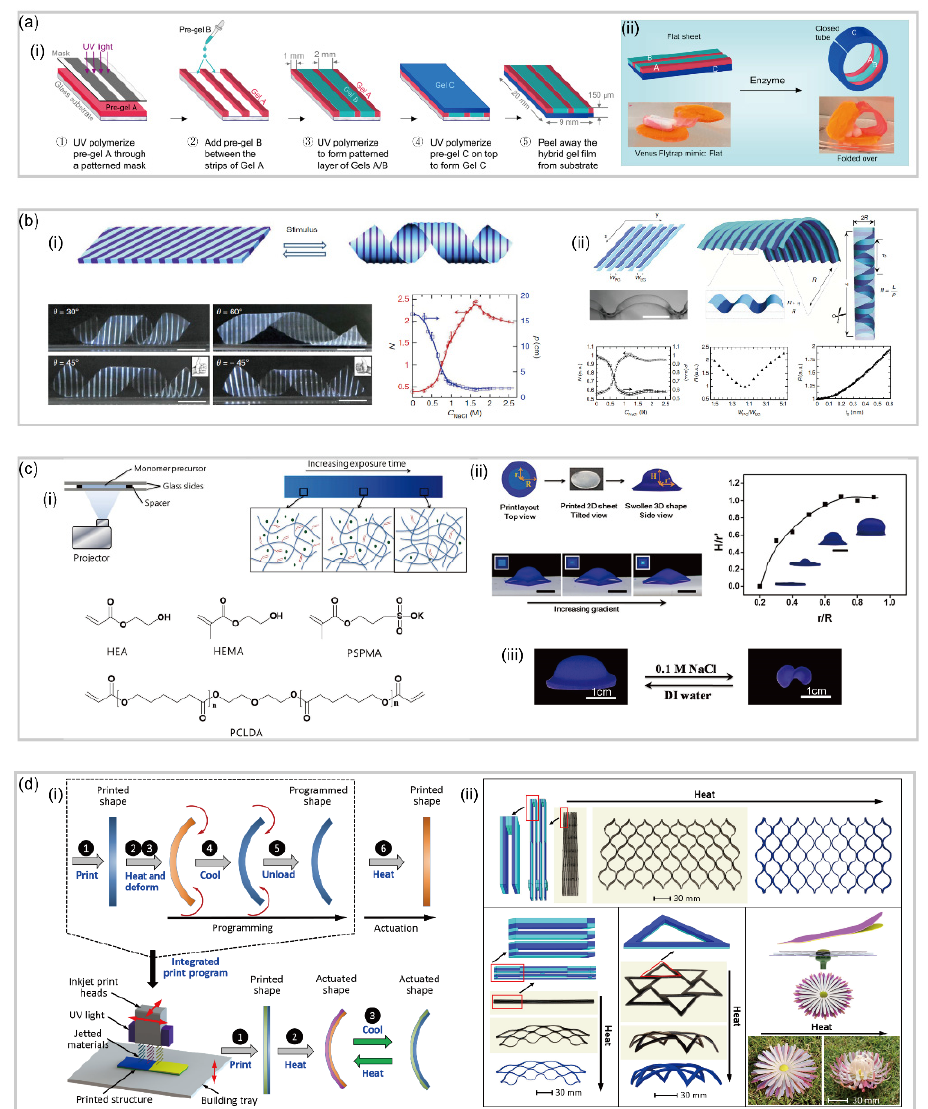
Figure 6. Pattern-based hydrogel soft robotics. ( a ) Fabrication of enzyme-responsive hydrogel actuator by UV-photolithography (reproduced with permission from Reference [72]). ( b ) Thermal responsive hydrogel actuator with periodic stripes (reproduced with permission from Reference [73]). ( c ) Experimental printing setup and process illustration from a planar sheet with patterned concentric circles swollen into a cap-shape 3D structure (reproduced with permission from Refer- ence [76]). ( d ) The concept of direct 4D printing and its versatility in printing various configura- tions with a single material (reproduced with permission from Reference [77]).